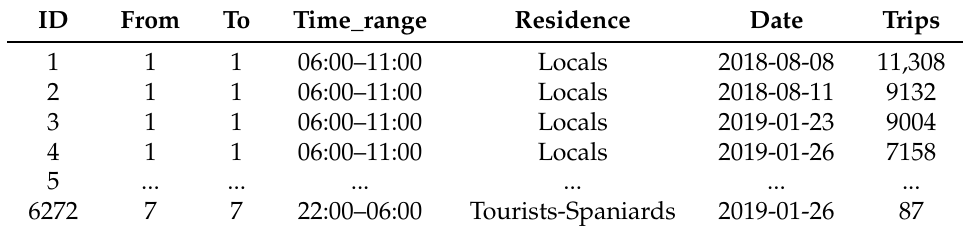
Table 4. Extract from the already pre-processed OD